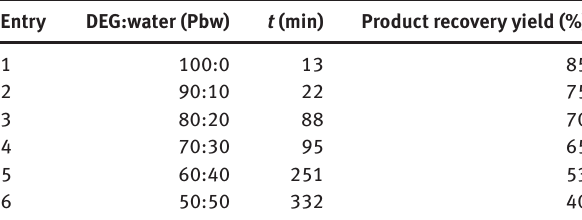
Table 1: DEG/water composition role using nano-TiO support in chemical recycling of PC wastes.